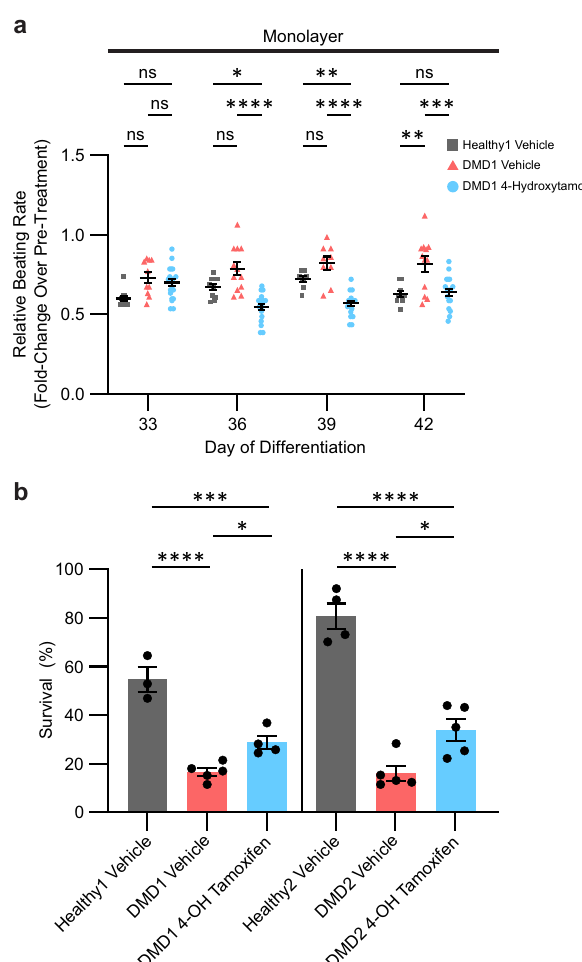
Fig. 4 Treatment with 4-hydroxytamoxifen decreases the beating rate and improves cell survival in monolayers. a Relative beating rate represented as fold change over pre-treatment (day 30) to chronic 0.5 μ M 4-hydroxytamoxifen or vehicle. n = 3 biological replicates, N = 9 – 22 regions. b Cell survival determined by Calcein Blue AM positive area on day 42 of differentiation relative to pre- treatment (day 30). n = 3 – 5 biological replicates. Cells were treated every 3 days beginning on day 30. Data represent mean ± SEM. Statistical signi fi cance determined by one-way ANOVA and Tukey test for post hoc comparison. * P < 0.05, ** P < 0.01, *** P < 0.001, **** P < 0.0001, ns (nonsigni fi